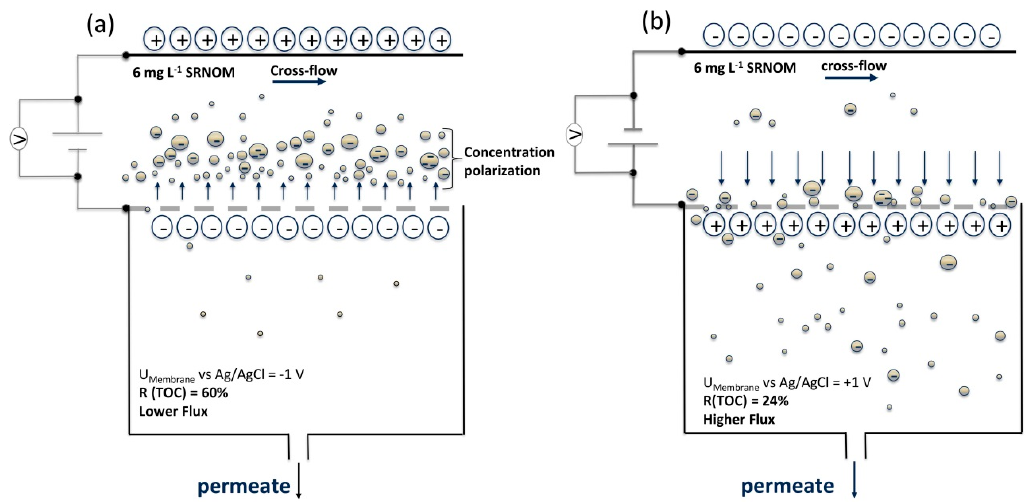
Figure 8. Model of NOM rejection on membrane surface with anodic and cathodic potential; ( a ) negatively charged membrane with high rejection due to electrostatic repulsion resulting in strong concentration polarization; ( b ) positively charged membrane with no electrostatic repulsion, higher flux and less rejection.